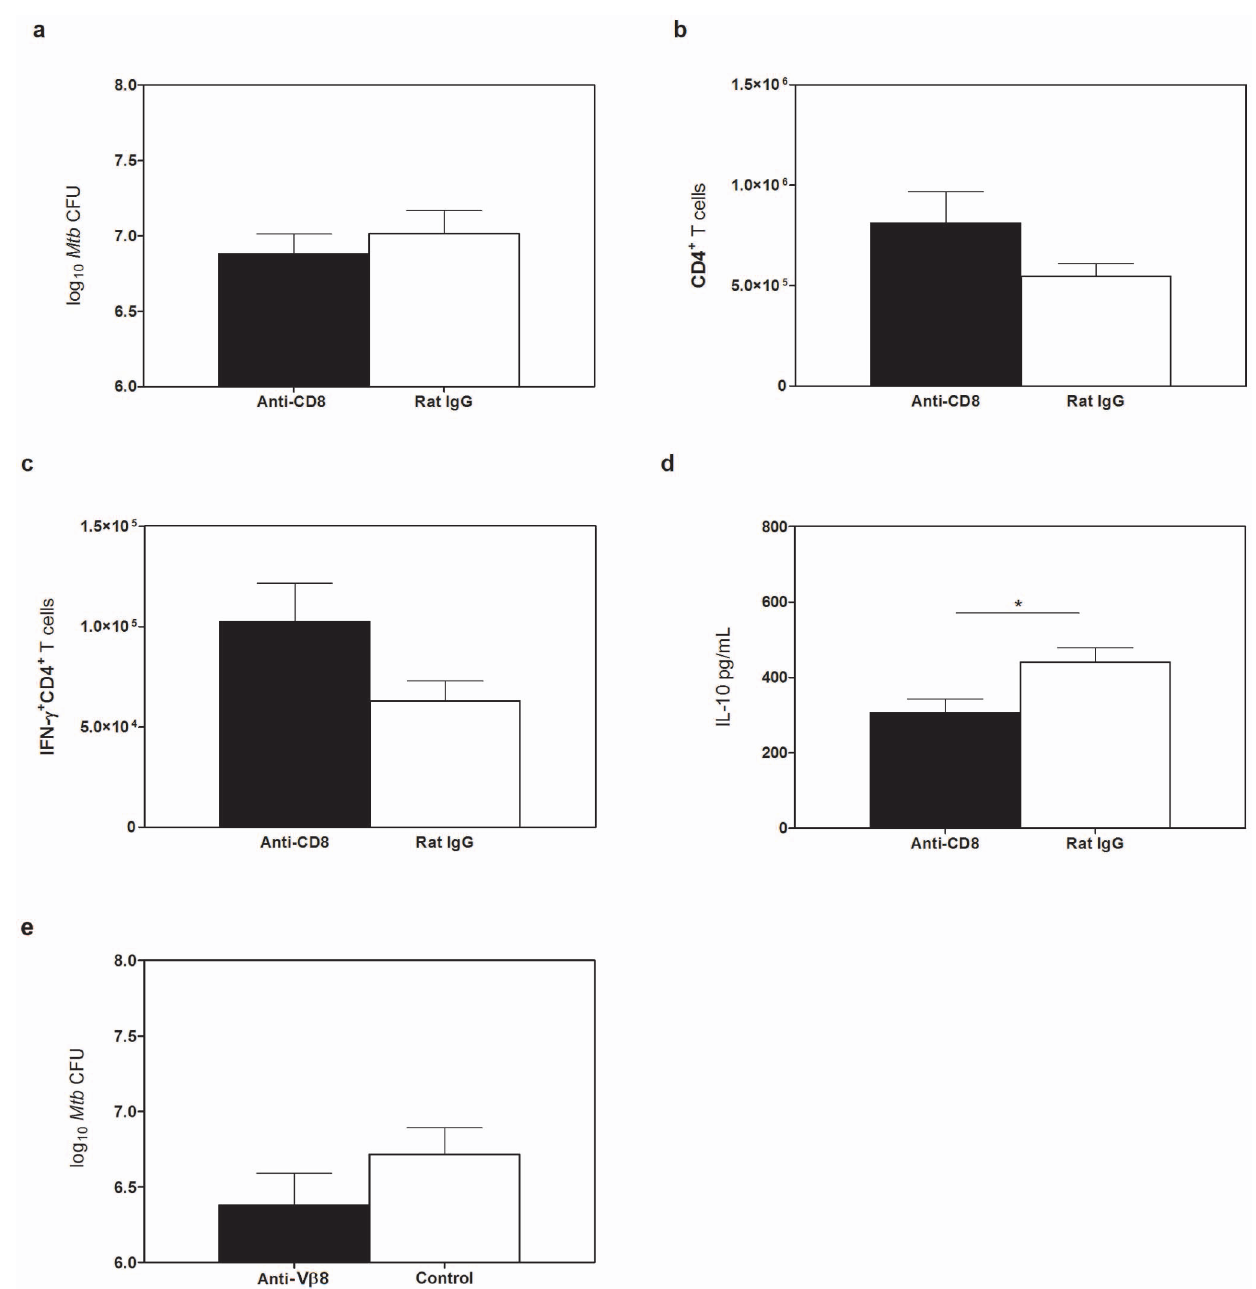
Figure 5. CD8 + T cell depletion in CBA/J mice. CBA/J mice were infected with an aerosolized dose of Mtb and from day 90–120 were treated weekly with depletion antibody via intraperitoneal injection then sacrificed at day 125 post-infection. ( a ) Lungs of anti-CD8 + T cell depleted or control mice were homogenized and plated on 7H11 plates and CFU enumerated after 21 days. Absolute number of total CD4 + T cells ( b ) or IFN- c + CD4 + T cells ( c ) after CD8 + T cell depletion as determined by flow cytometry. ( d ) Levels of pulmonary IL-10 after CD8 + T cell depletion as determined by ELISA. ( e ) Lungs of anti-V b 8 depleted or control mice were homogenized and plated onto 7H11 plates and CFU enumerated. Control group = no treatment and isotype control. Results representative of at least two independent experiments with 5–10 mice per group. Depletion resulted in 95% reduction in cell number, as determined by flow cytometry. * p , 0.05, ** p , 0.01, *** p , 0.001 as obtained by Student’s t test.